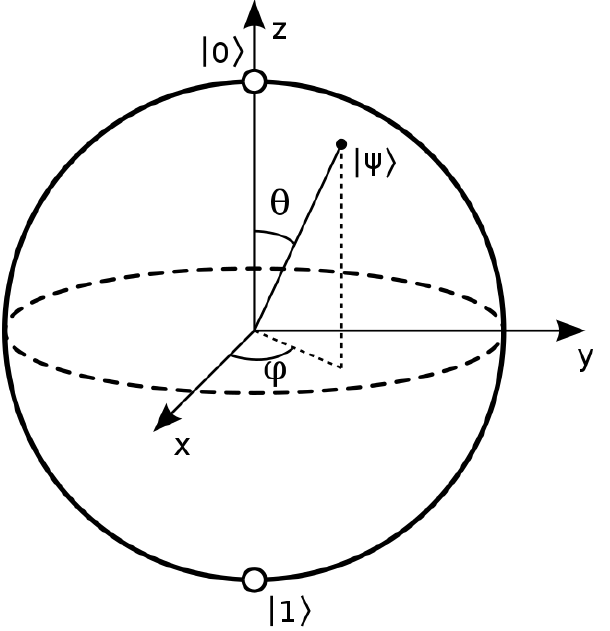
Figure 2. The Bloch Sphere, the geometrical representation of the pure state space of a two-level quantum mechanical system, i.e., a qubit